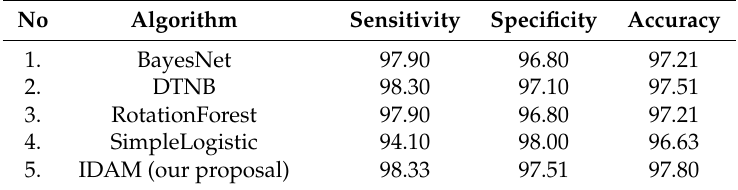
Table 4. Classification accuracy of the five best-performing algorithms using e-Health Sensor Platform Dataset. No